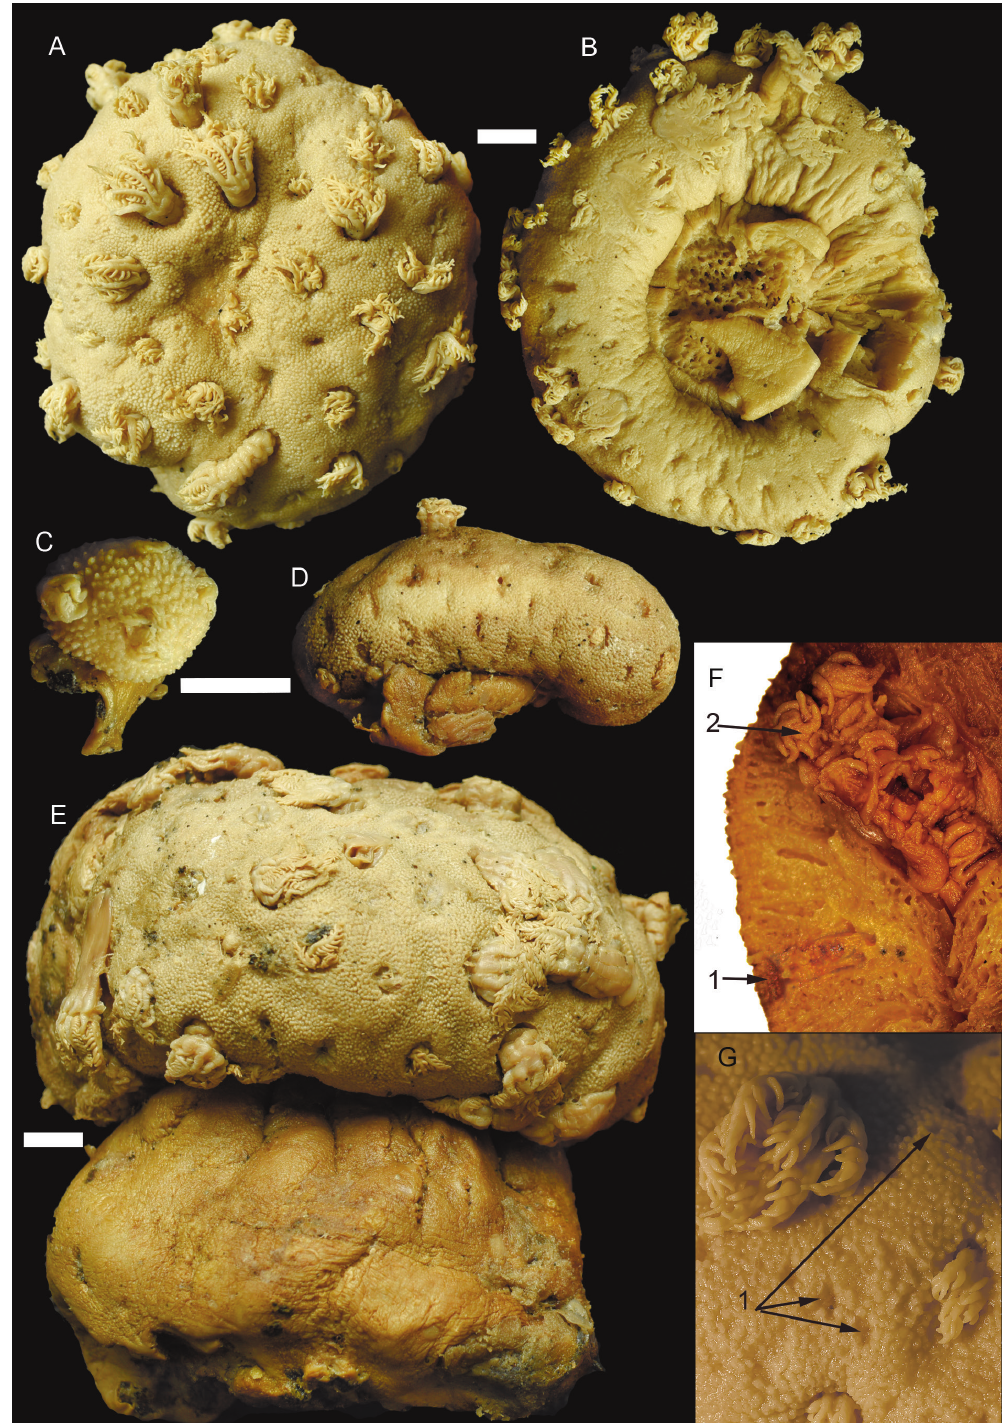
Fig. 1. Heteropolypus annae sp. nov. A . Holotype (MIMB 42493), Kurile Islands, Sea of Okhotsk. View from above. B . Holotype (MIMB 42493), Kurile Islands, Sea of Okhotsk. View from below. C . One specimen, Kurile Islands, Sea of Okhotsk (MIMB 42496). D . One specimen, Kurile Islands, Sea of Okhotsk (MIMB 42496). E . Paratype (MIMB 42494), Kurile Islands, Sea of Okhotsk. F . Holotype (MIMB 42493); section of the capitulum; 1 = autozooid, 2 = mesozooid. G . Holotype (MIMB 42493); surface of the capitulum; 1 = mesozooids. Scale bars: A–E = 10 mm; F–G = not to